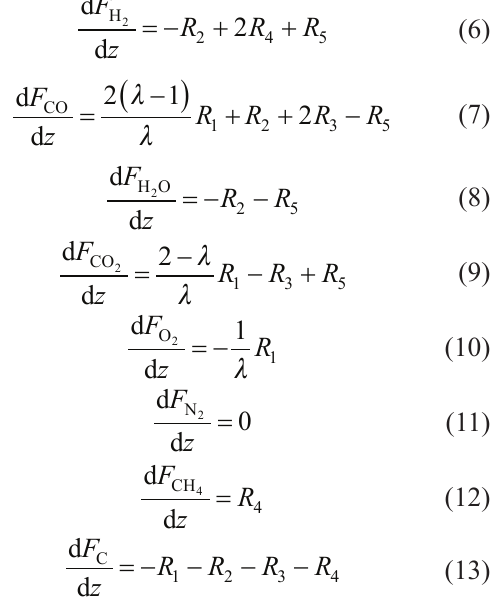
Carbon-oxygen reaction